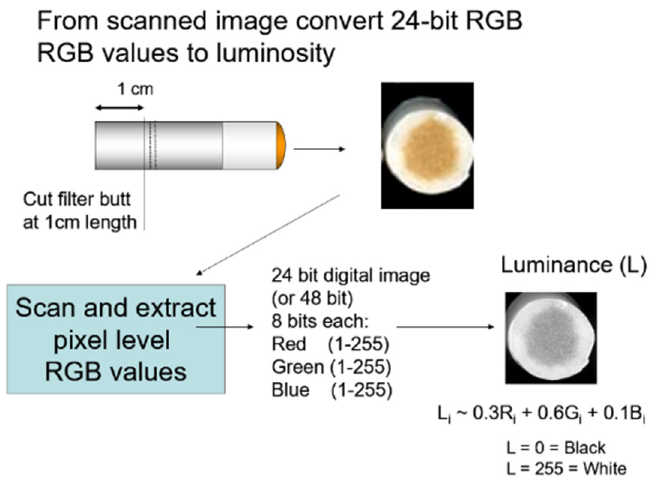
Figure 2. Example of captured image and determination of the corresponding luminosity value (1- 255).